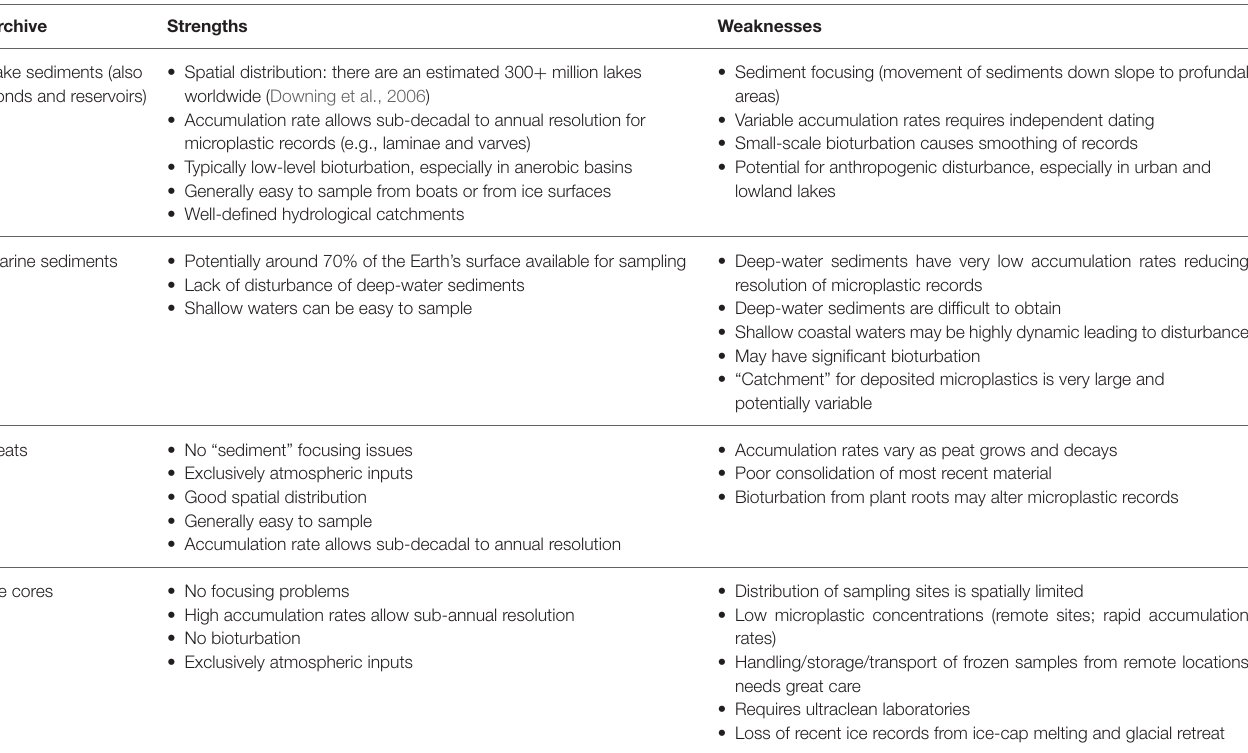
TABLE 1 | Strengths and weaknesses of the principal natural archives for microplastic records. Archive